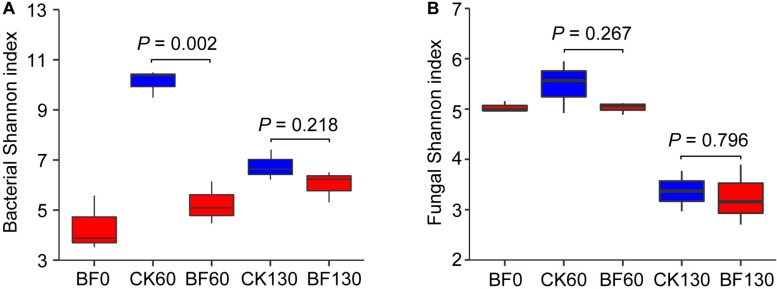
Shannon index of bacteria (A) and fungi (B).